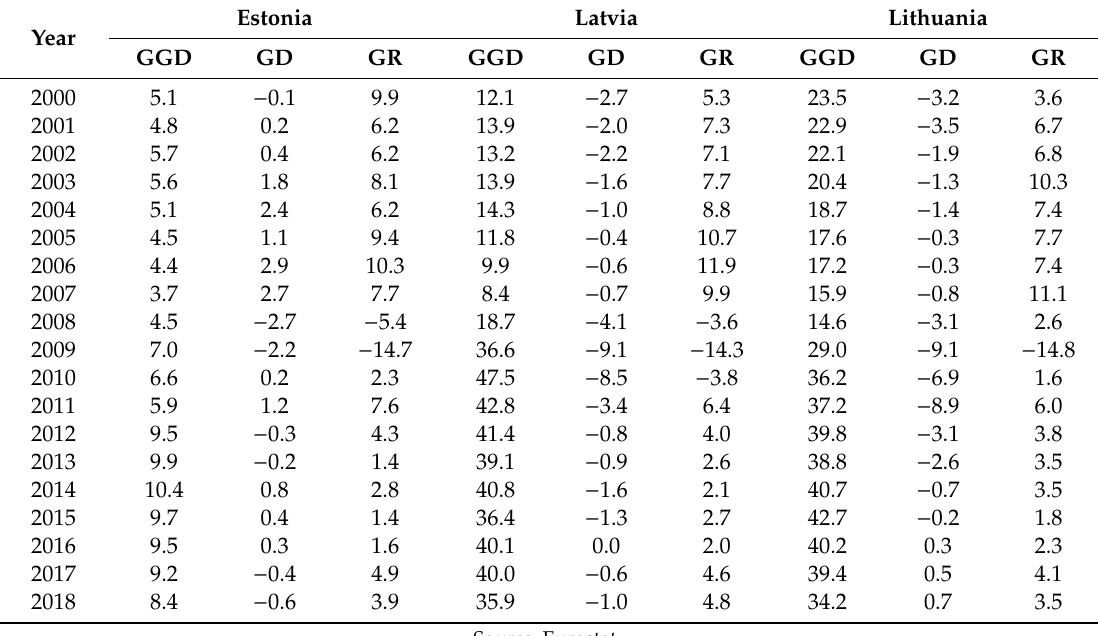
Table 1. The Baltic countries’ GGD percentage of GDP, GD percentage of GDP, and growth rate percentage change from previous year, 2000–2018.